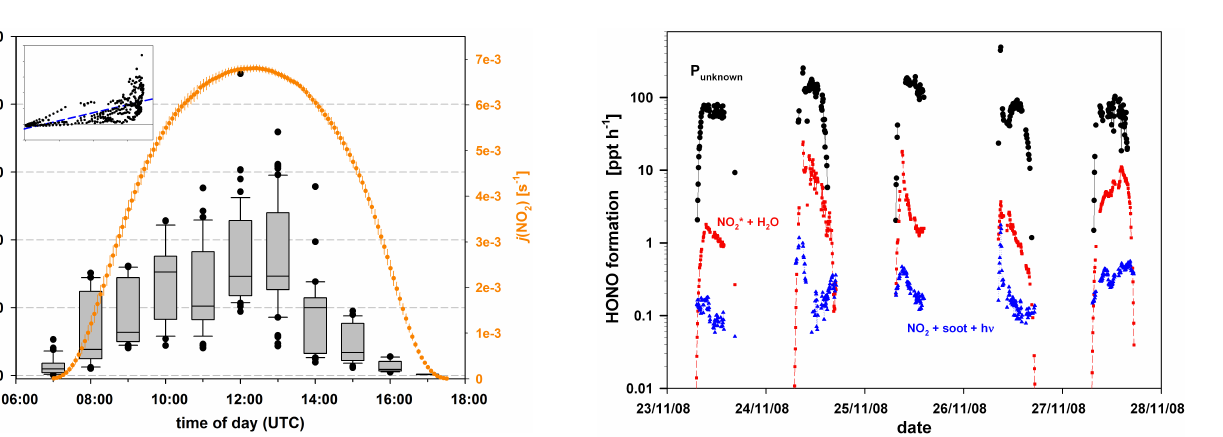
Fig. 6. Comparison of different HONO daytime source strengths (blue: NO 2 + soot + hν (Monge et al., 2010); red: NO 2 * + H 2 O, Li et al., 2008) with the unknown HONO daytime source